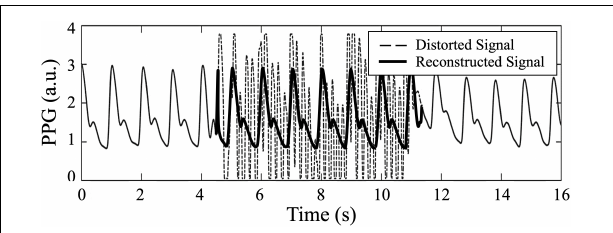
FIGURE 7 | Example of PPG waveform reconstruction. Dashed line is distorted PPG, while bold line is reconstructed